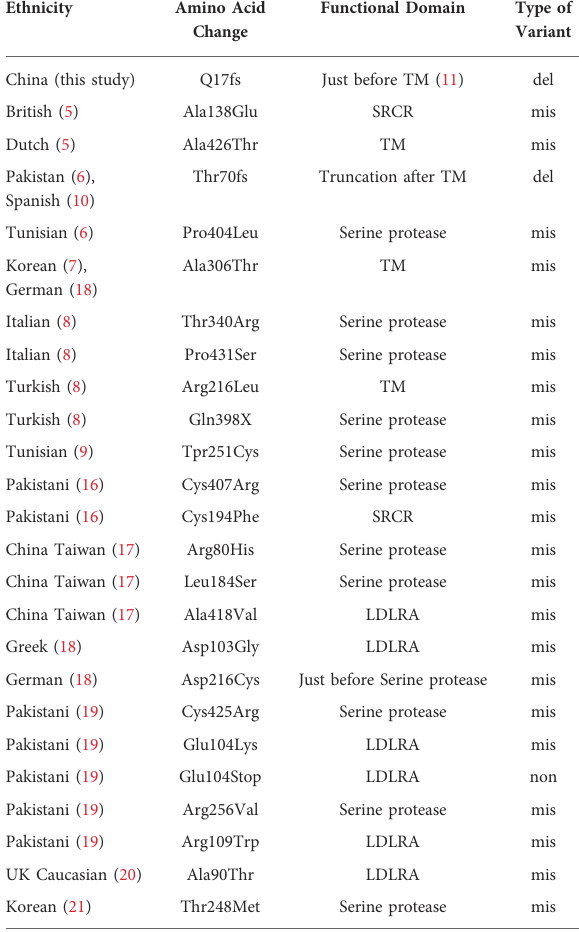
Table 1 Overview of the part of deafness-associated mutations in TMPRSS3 .